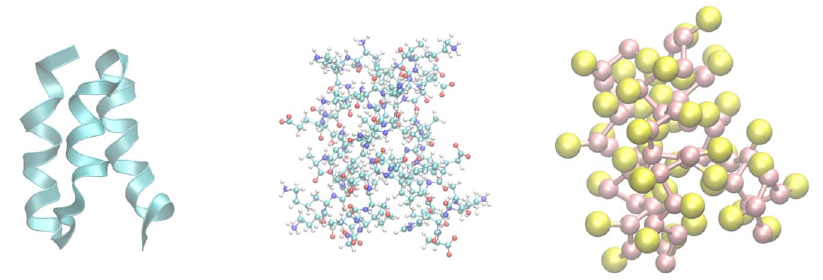
Figure 1. The native structure of the GA module of an albumin binding domain. Three representations of the structure are shown. The left panel shows the backbone of the native fold as a ribbon, which highlights the helical nature of the secondary structure. The center panel shows the AA structure, which is used to build the KT G (cid:2) oo model (right panel).